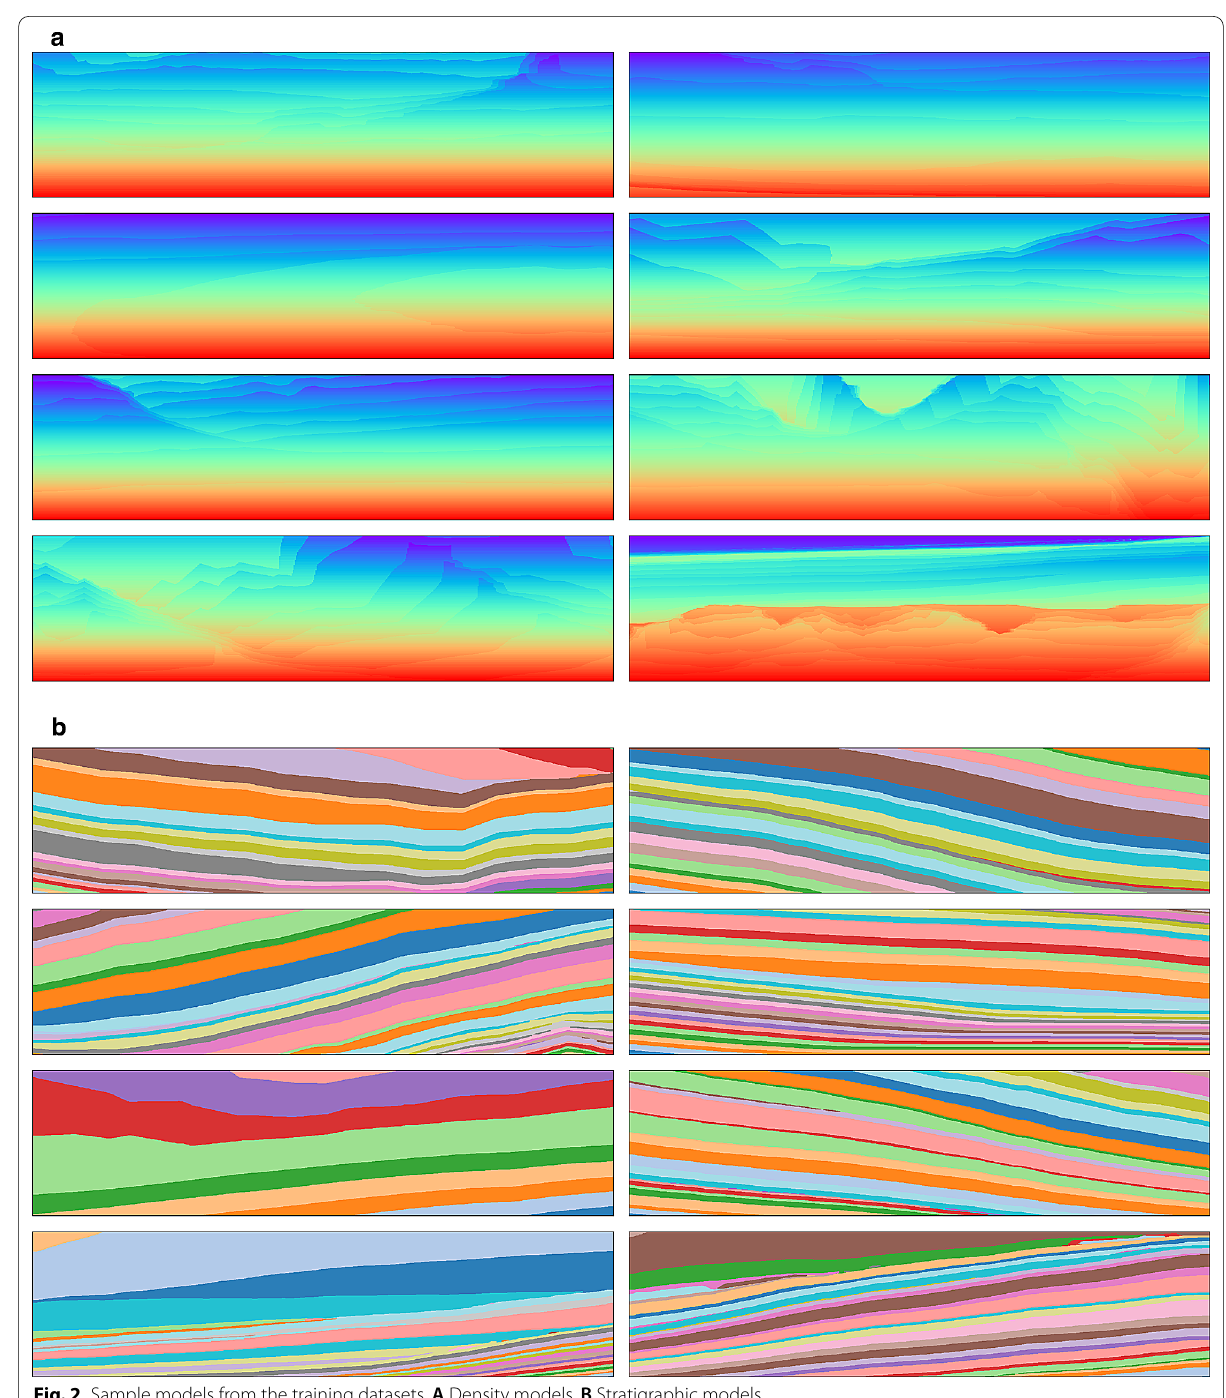
Fig. 2 Sample models from the training datasets. A Density models. B Stratigraphic